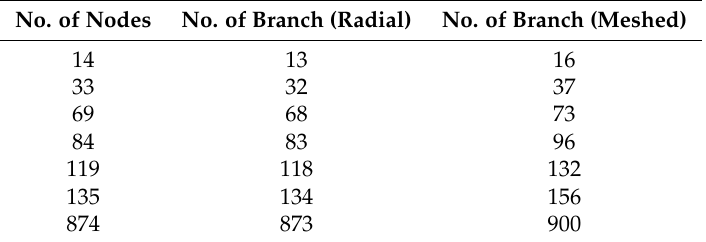
Table 2. Network